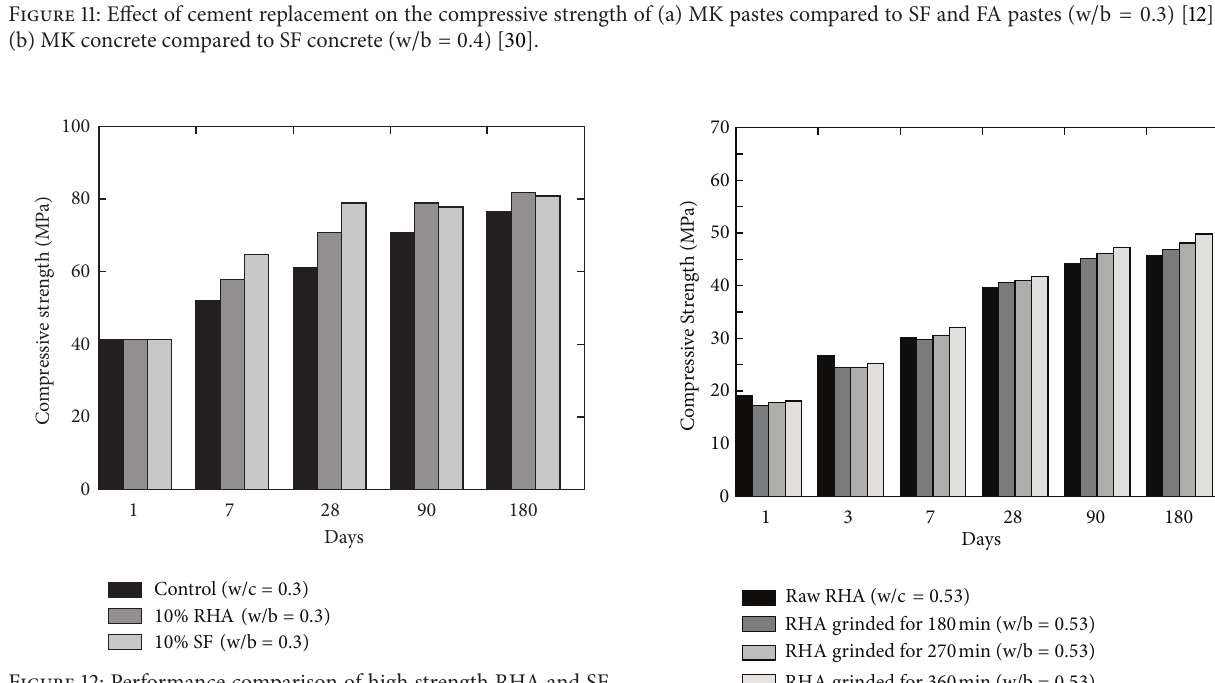
Figure 12: Performance comparison of high strength RHA and SF [21].